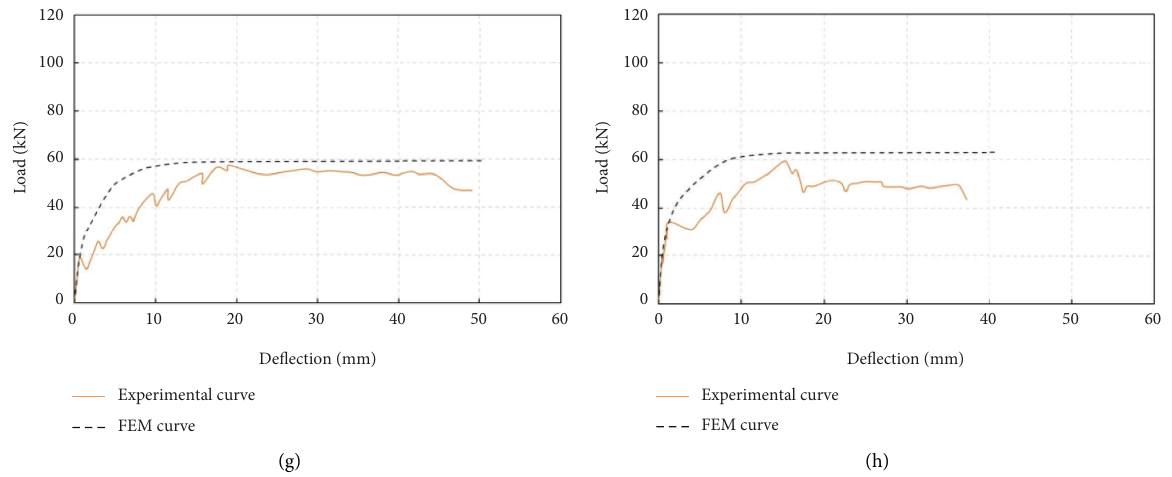
Figure 15: Comparison of numerical and experimental load-defection curves. (a) G24-I, (b) G24-II, (c) G24S10-I, (d) G24S20-I, (e) G34-I, (f) G24A0.2-I, (g) G26-I, and (h) G26-II. Table 7: Comparison of the ultimate load between numerical and experimental results.